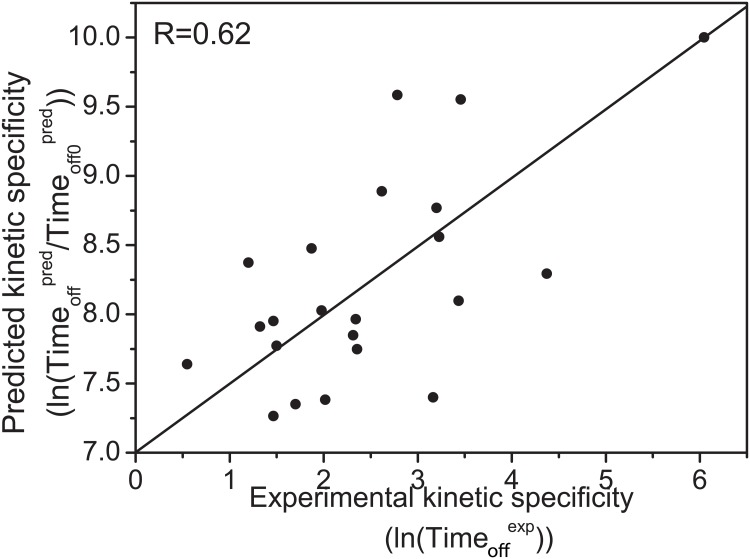
The relationship between the predicted and experimental kinetic specificities for 22 drugs against the Cox-2.
Timeoffpred represents the relative predicted residence time and Time
off0
pred is the constant weighting factor, Timeoffexp is the experimental residence time.